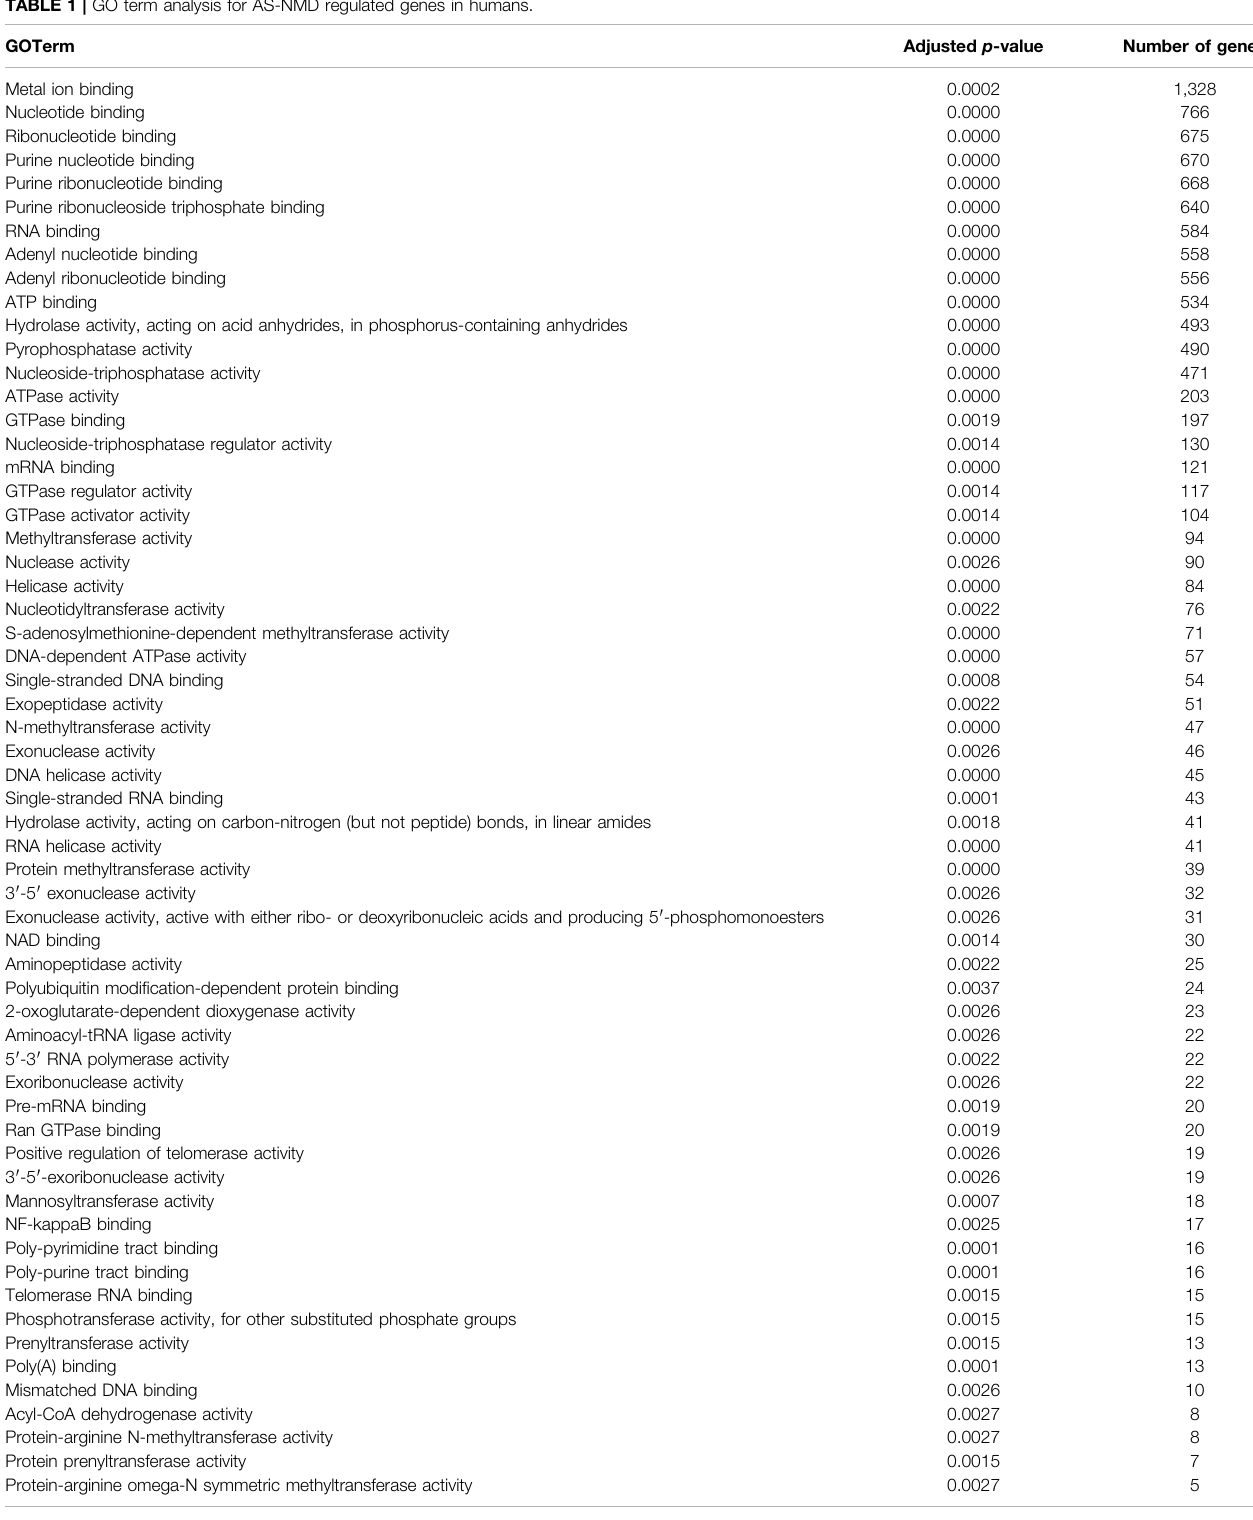
TABLE 1 | GO term analysis for AS-NMD regulated genes in